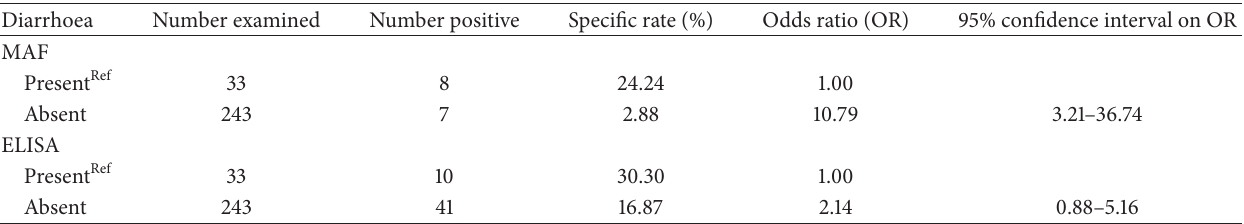
Table 3: Odds ratio and 95% confidence interval on effect of diarrhoea on the prevalence of Cryptosporidium infection in dogs using MAF and ELISA in the FCT, Abuja.